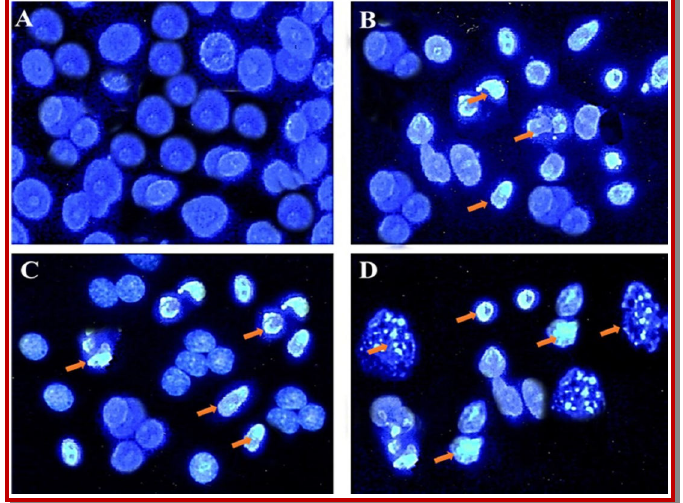
Figure 5: Corosolic acid induces apoptotic morphological features in CaSki cervical cancer cells. The cells were treated without (A, untreated control), and with 10, 50 and 100 µM of corosolic acid for 48 hours. The orange arrows represent cells which have undergone apoptosis. The images were captured using a fluorescence microscope